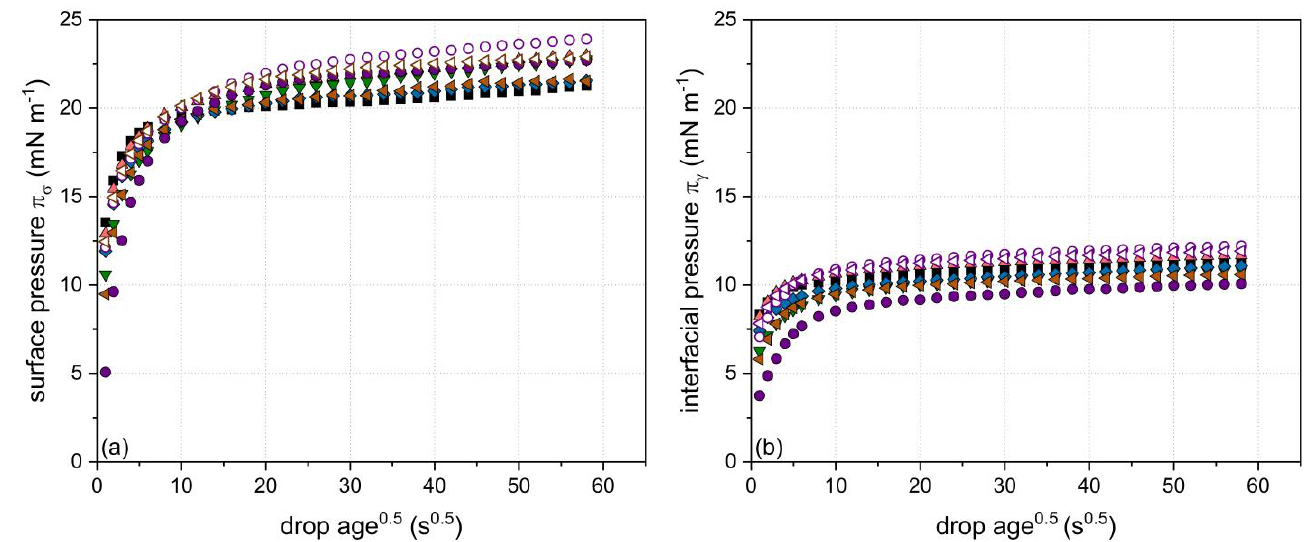
Figure 7. Evolution of ( a ) surface pressure π σ at the air/water interface and ( b ) interfacial pressure π γ at the oil/water interface as a function of the particle properties using a particle concentration of 8.2 g L − 1 (median particle size: ■ 3, ◆ 20, ▼ 22, ▲ 22, ◁ 40, ◀ 44, ○ 119, and ● 120 nm). For further interpretation of the symbols, the reader is referred to Table 2.